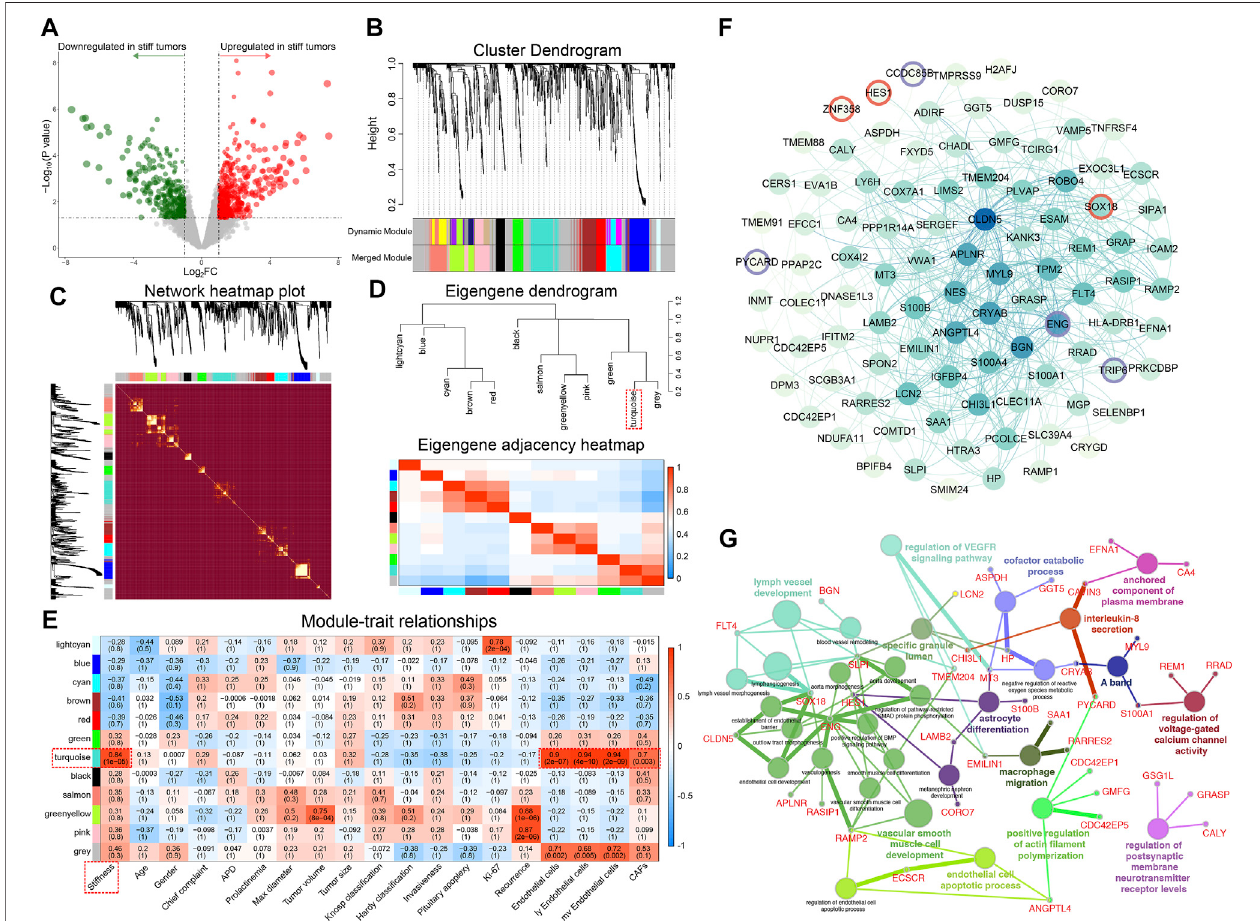
FIGURE3| Identi fi cationofthetopstiffness-relatedgenemoduleofPAsbyWGCNA. (A) VolcanoplotdisplayingtheDEGsbetweenstiffandsofttumors.Reddots represent the upregulated genes, and green dots represent the downregulated genes in the stiff PAs. (B) Cluster dendrogram of the DEGs. Upper panel: Each branch represents one single gene. Lower panel: Each color represents one coexpression module. (C) Heatmap illustrating the interactions of coexpressed genes. The brightness of yellow in the heatmap represents the degree of connectivity of different modules, with a lighter color indicating greater overlap. The colors of the horizontal and vertical axes represent different modules, and the branches represent different genes. (D) Upper panel: Hierarchical clustering of module genes. Lower panel: Heatmap of the adjacencies in the module gene network. (E) Heatmap displaying the correlations between module eigengenes and the clinical traits of patients with PA. The turquoise module was the most critical module and was positively correlated with stiffness, general ECs, lymphatic ECs, microvascular ECs, and CAFs. (F) PPInetworkincluding 131SRGsfromtheturquoise module. Achange indotcolorfrom lightertodarkerindicates anincreasingdegree ofgeneconnectivity. Redcircles represent TFs, and purple circles represent TF cofactors. (G) Functional enrichment analysis of the SRGs. Different dot colors indicate different GO clusters.